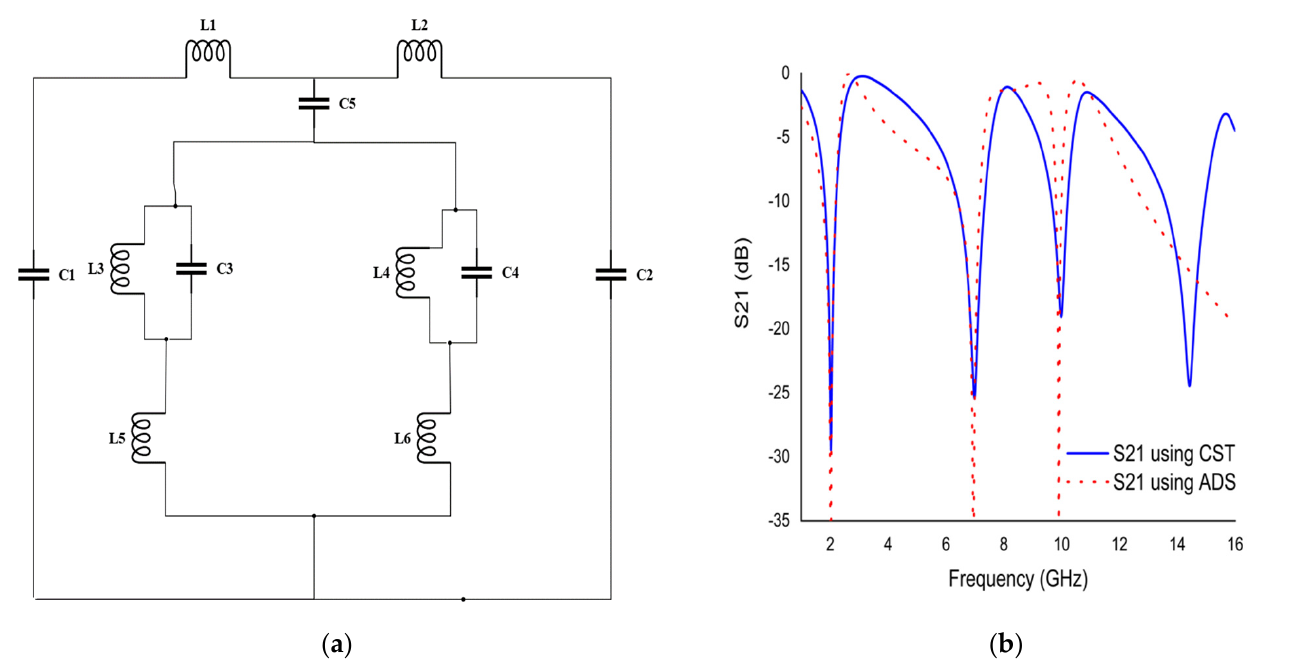
Figure 7. ( a ) Equivalent circuit model of unit cell. ( b ) S21 plot using CST and ADS